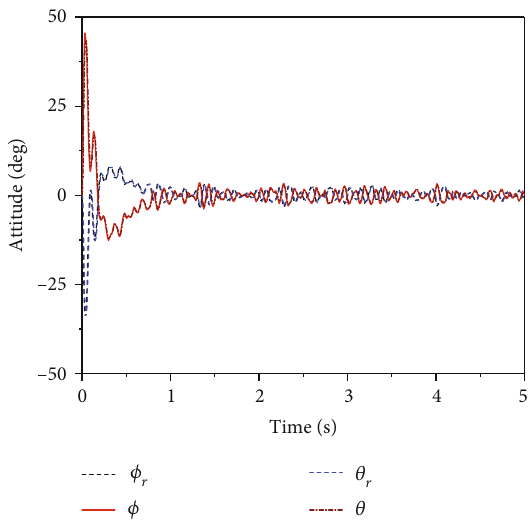
Figure 7: Response of the roll angle and pitch angle.